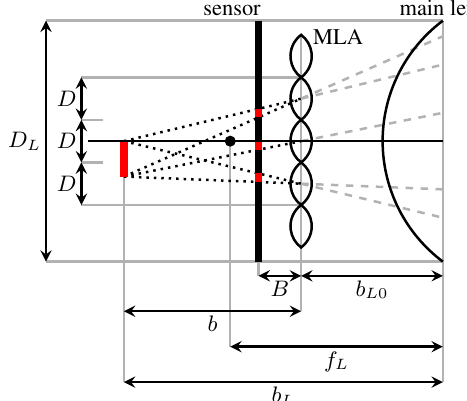
Figure 2: Optical path inside a Raytrix camera